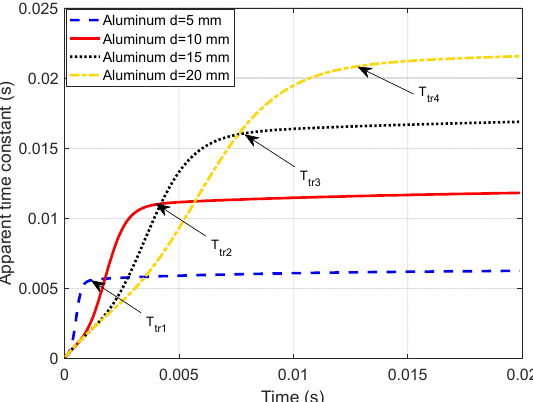
Figure 4. Characterization of D-ATC curve to the thickness of aluminum plate with a large lift-off of 100 mm. The increase in the thickness of the aluminum plate prolongs the transient time of the D-ATC curves and improves its steady-state value.